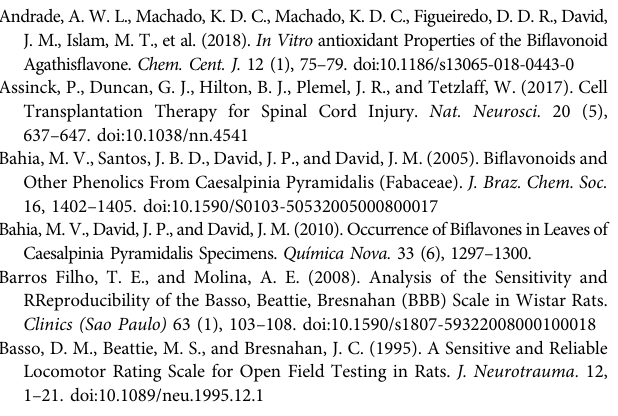
Supplementary Figure S2 | Characterization of rat mesenchymal stem cells (rMSCs) by fl ow cytometry surface markers for the Ratus